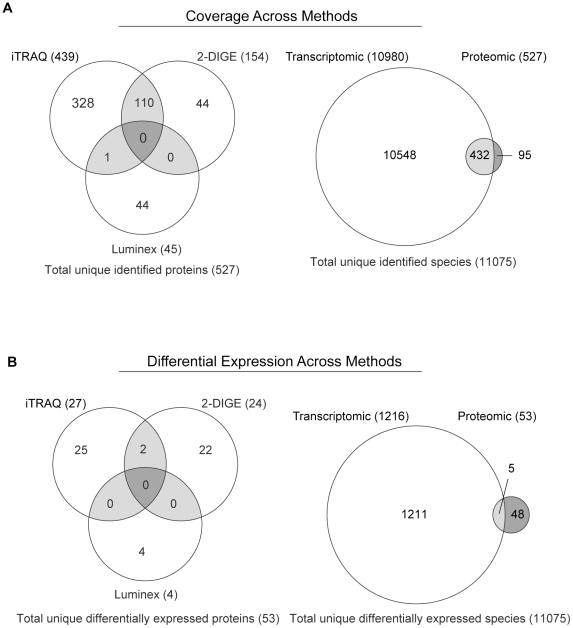
Coverage and differential expression across analysis methods.Bioinformatic comparison of datasets generated by the three proteomic and one transcriptomic approaches used was performed to compare commonalities and differences in coverage and differential expression. (A) Comparison of proteomic coverage of unique species identified across methods is illustrated by Venn diagram. iTRAQ, DIGE and Luminex provided complementary coverage with limited overlap between methods. Of the 527 unique proteins identified in this study, 110 were identified by both iTRAQ and DIGE, and only one protein included in the directed Luminex analysis was also identified by an open-profiling method. For the majority of identified proteins, corresponding transcripts were present at detectable level in the transcriptomic analysis. The greater coverage of the transcriptomic data compared to the proteomic coverage is primarily due to the greater sensitivity of the whole-genome microarray approach. (B) Comparison of differentially expressed species detected by each method is depicted. As with proteomic coverage, quantitative data proved complementary across methods, with a different subset of differentially expressed proteins detected by each of the three proteomic approaches. In the two cases where a protein was differentially-expressed in both iTRAQ and DIGE quantitation, the direction and magnitude of change were comparable. Numerous differentially-expressed transcripts were identified by microarray analysis, although only a portion of the proteomic changes were detected at the transcript level.